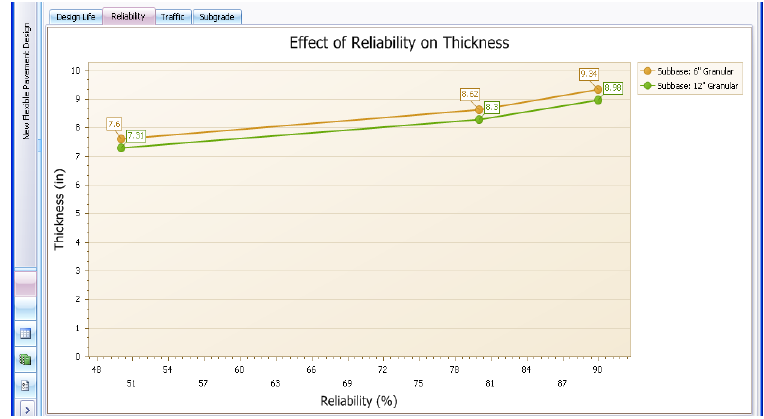
Figure 9. Screenshots of sensitivity analysis of reliability on asphalt pavement thickness.